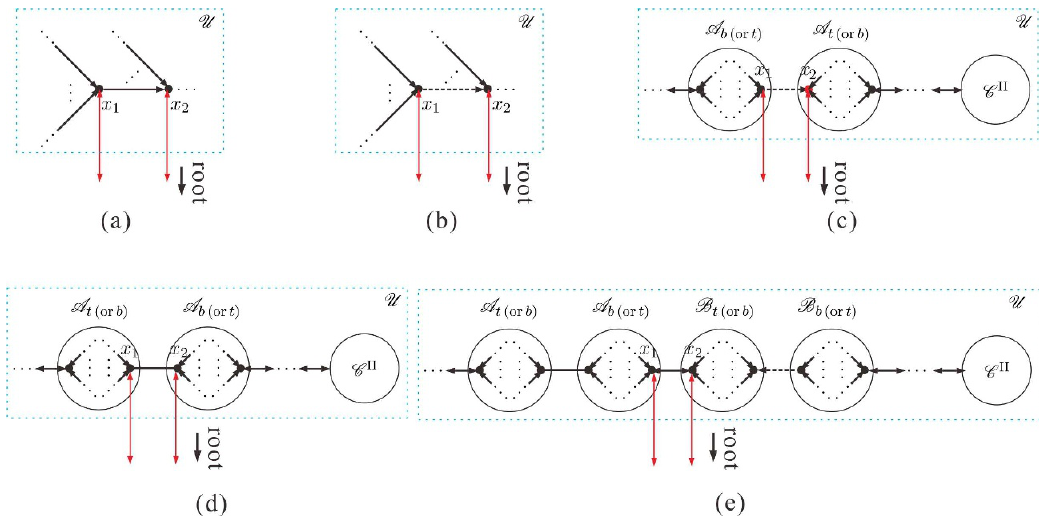
Figure 19 . All possible situations when choosing x 2 U as two adjacent nodes x 1 and x 2